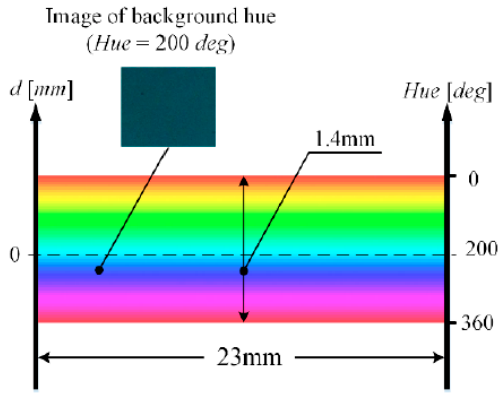
Figure 29. Rainbow filter with hue value. Reprinted with permission from Ref. [45] (2018).